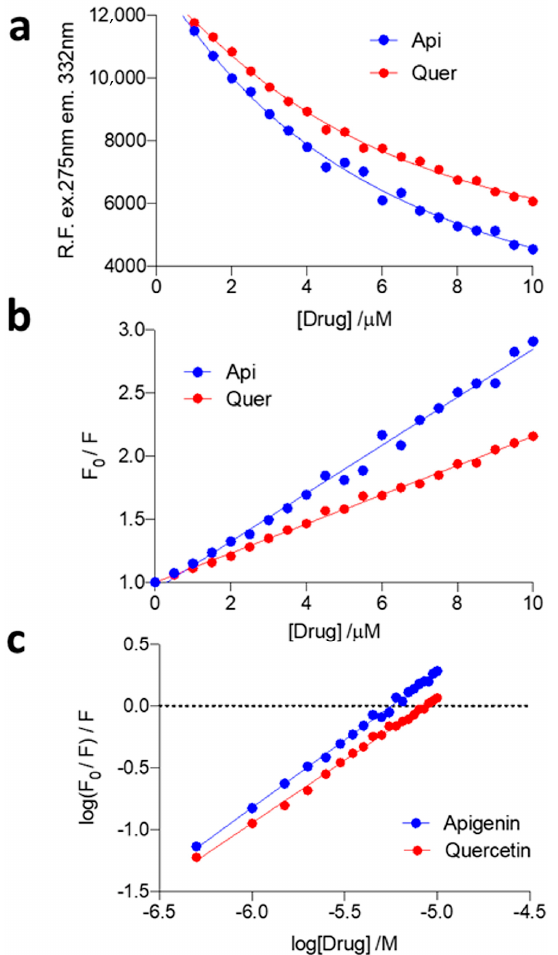
Figure 10. Fluorescence quenching of AChE by quercetin and apigenin (Drug in the plots). ( a ) In- trinsic fluorescence emission of AChE upon addition of increasing amounts of quercetin (red) and apigenin (blue). ( b ) Stern–Volmer plots, viz. F 0 /F vs. [flavonoid] showing the quenching of AChE fluorescence in the presence of increasing amounts of quercetin (red) and apigenin (blue). ( c ) Relationship between the binding affinities and the numbers of binding sites for the interaction between AChE and apigenin (blue) and between AChE and quercetin (red). λ exc = 275 nm, λ em = 332 nm. Table 5. Binding affinities ( K a ) and numbers of binding sites ( n ) for the interaction of apigenin and quercetin with AChE.